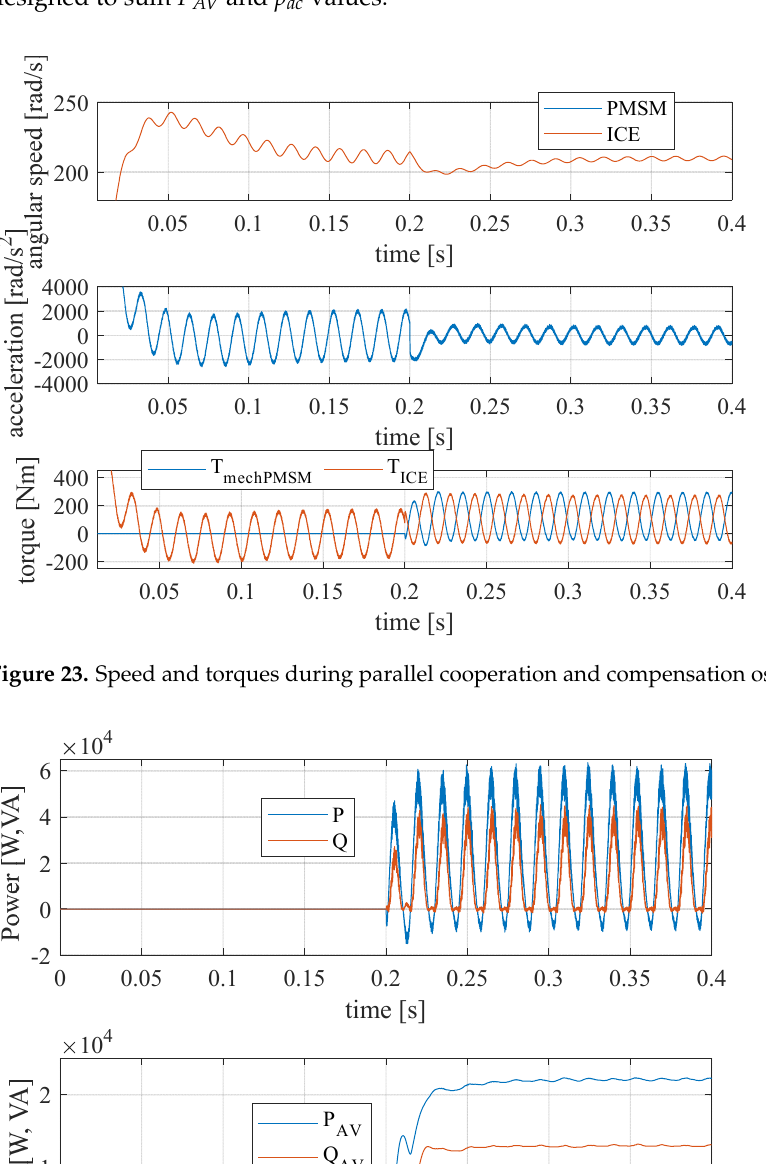
Figure 25. AC components of power during parallel cooperation and compensation oscillating torques. •